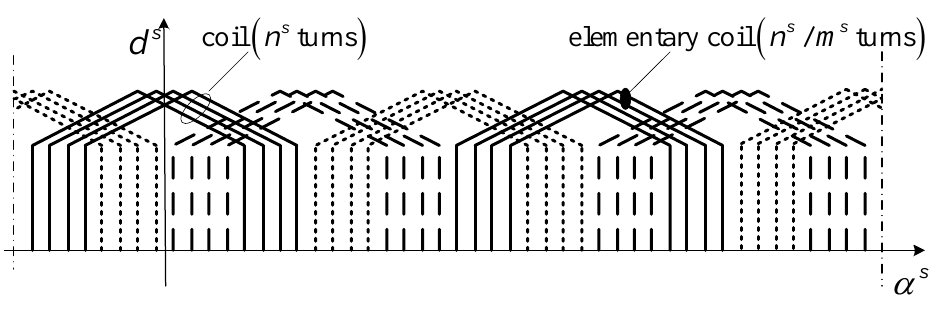
Figure 4. Three phase stator windings